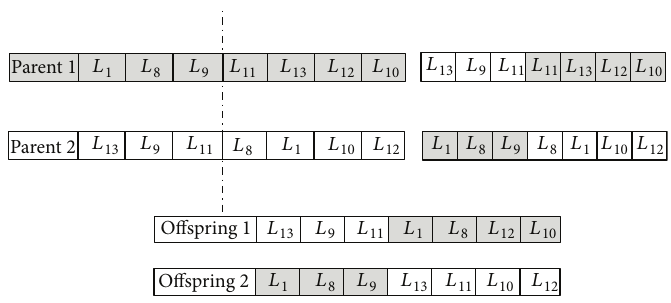
Figure 3: Crossover operation.